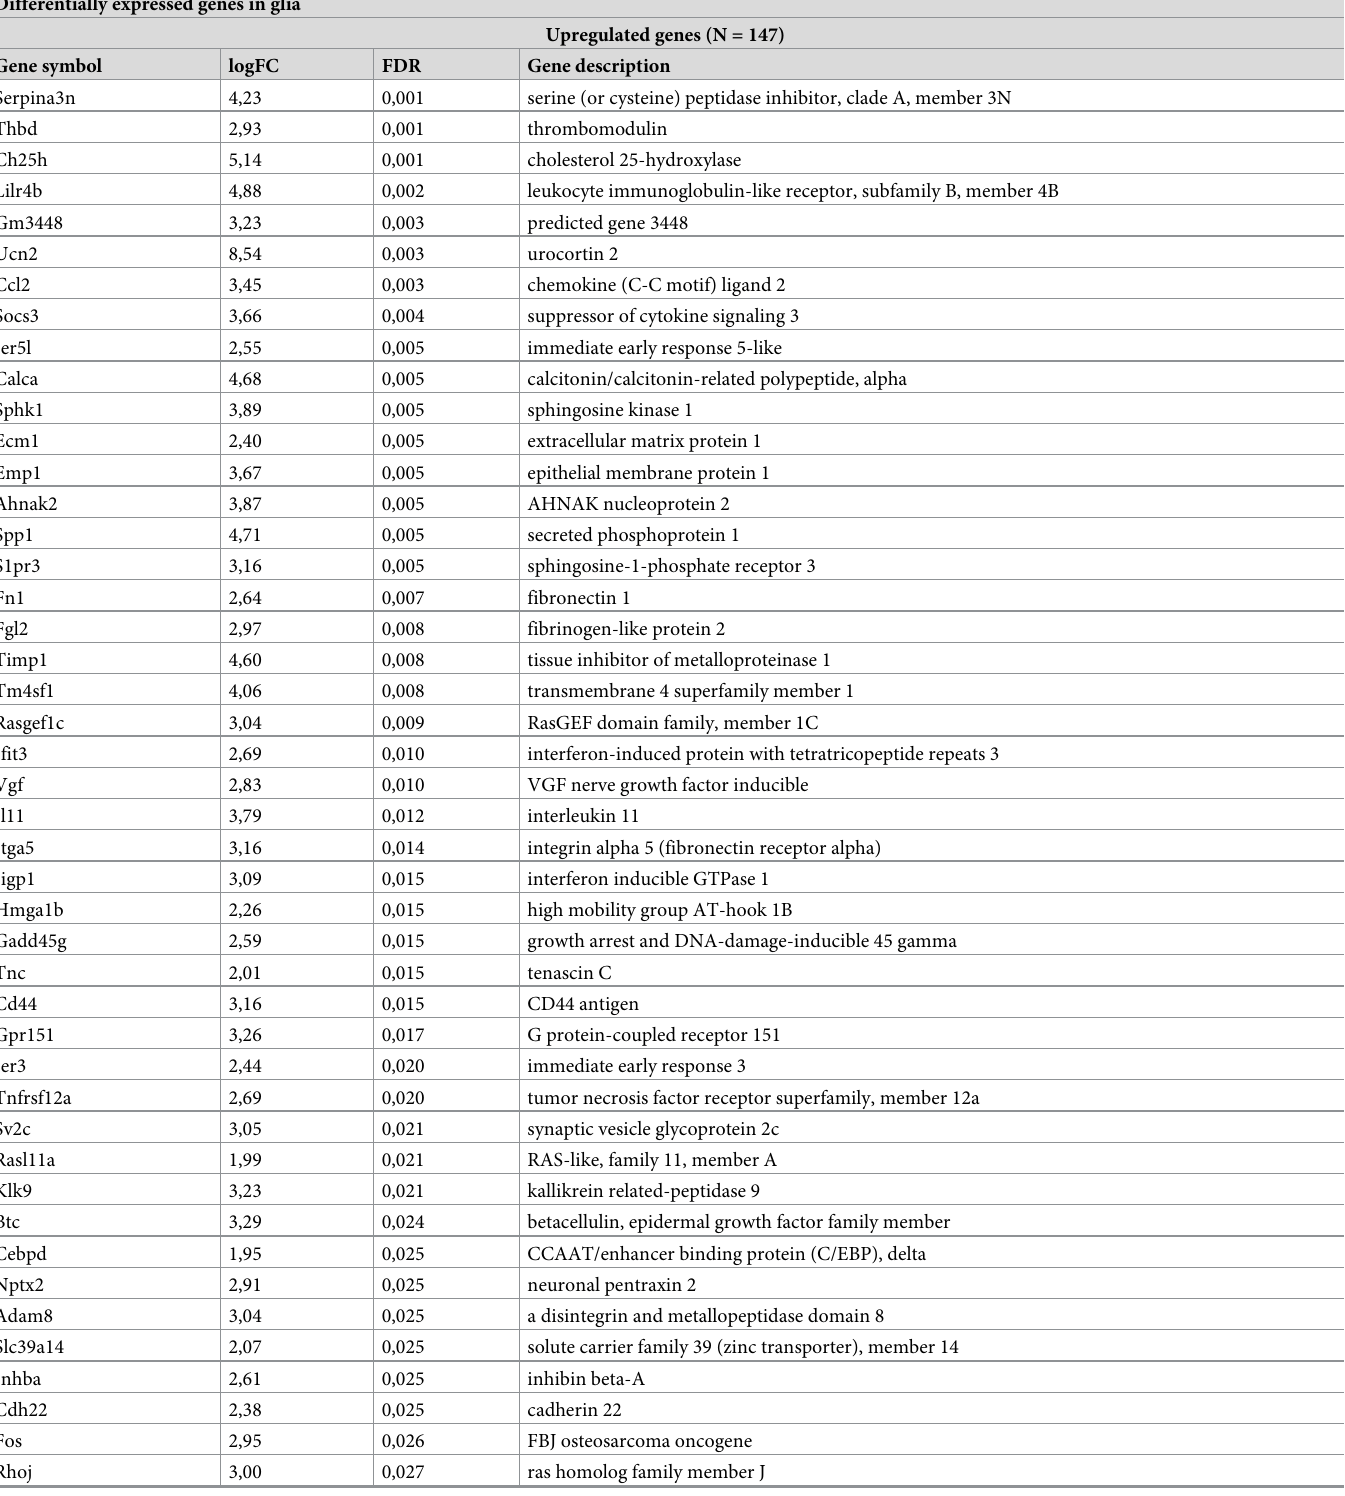
Table 2. Differentially expressed genes in glia at 24 hours post injection in the intracortical kainic acid model of mTLE. Differentially expressed genes in